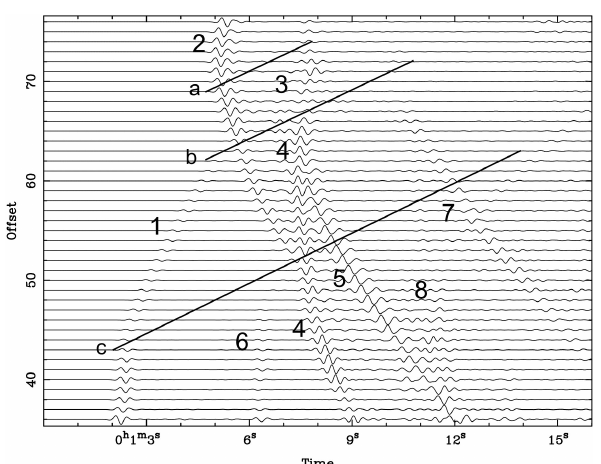
Fig. 10: Model with DSC: time-reduced record section of synthetic horizontal component seismograms computed at receivers at the surface. Numbers from 1 to 7 mark major seismic phases. (1) P wave refracted at the interface between subducted oceanic crust and lithospheric mantle, (2) direct P phase, (3) and (3’) two guided P phases emerging from the deep oceanic crust and radiated into the serpentinized man- tle wedge, (4) and (4’) guided P phases emerging from the deep oceanic crust staying attached to the oceanic crust, (6) refracted S phase converted from direct P phase at interface between subducted oceanic crust and lithospheric mantle, (7) S conversion of upgoing guided phases 3 at serpentinized wedge–crust interface. Solid lines crossing seismograms in- dicate lines of constant time for comparison with snapshots a–c of Fig. 8 on the left. Associated times from top to bottom are t = 24 . 2 s, 27.5 s, 36.3 s. Source is explosive at 108 km